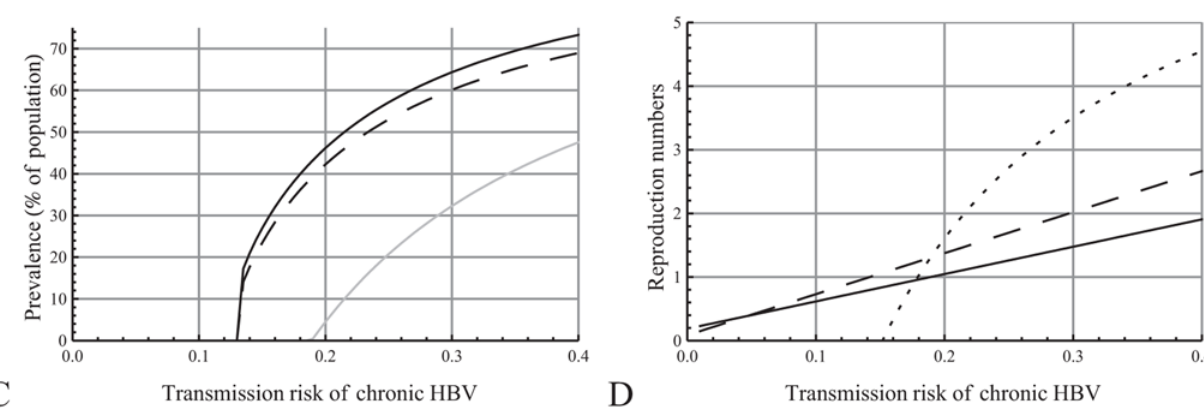
Figure 2. The impact of measures changing the infectivity of chronic hepatitis B virus (HBV). The transmission probability of chronic HBV from individuals with single HBV infection ( p b 2 ) was varied from 0 to 0.4. A, B: hepatitis D reduces HBV infectivity by 50% in individuals dually infected ( q b 2 ~ 0 : 5 p b 2 ); C, D: hepatitis D does not suppress HBV replication ( q b 2 ~ p b 2 ). Left panels show the total prevalence of HBV (black solid line), the prevalence of hepatitis D (black dashed line), and the prevalence of HBV in a population without hepatitis D (grey line). Right panels show the reproduction numbers R b (solid line), R bd (dashed line), and ^ RR bd (dotted line).